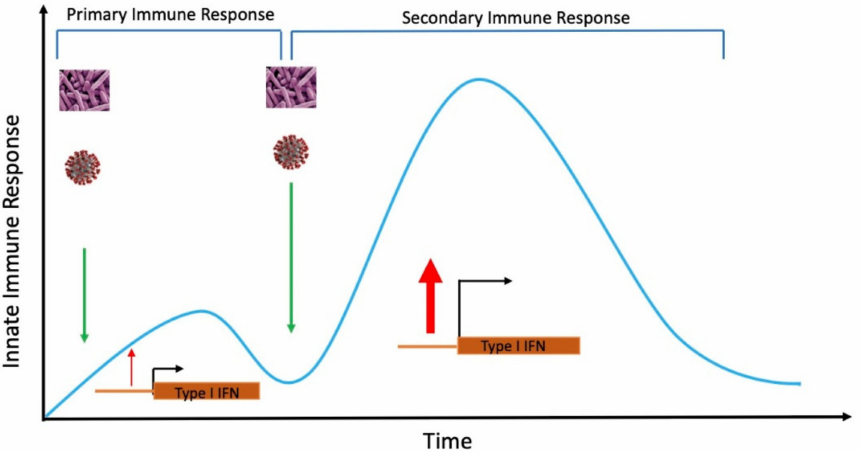
Figure 3. Vaccination to train host immunity improves the anti-viral or bacterial host defense by enhancing the innate immune response. Type I IFN response enhances primary infection, which is further enhanced by several folds after secondary